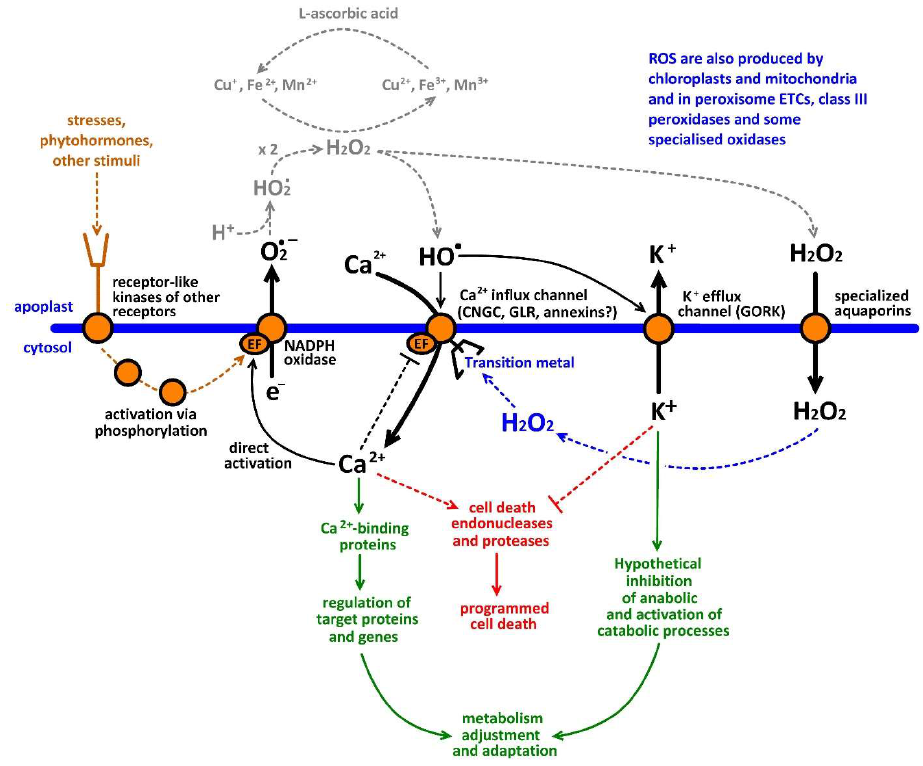
Figure 1. The concept of reactive oxygen species (ROS)-Ca 2+ -hub in the plasma membrane of higher plants. Stresses and regulatory stimuli can react with cell surface receptors leading to the activation of NADPH-oxidases (or directly activate ion channels). NADPH oxidases produce superoxide (O 2 •− ), which binds H + and forms hydroperoxyl radicals (HO • 2 ), which undergo dismutation reaction forming H 2 O 2 . H 2 O 2 can be reduced in Haber-Weiss cycle using electrons from transition metals, which can be reduced by L -ascorbic acid. H 2 O 2 reduction leads for formation of HO • in the close proximity (clusters) to ROS-activated Ca 2+ -permeable cation channels. Cell wall transition metals are required for